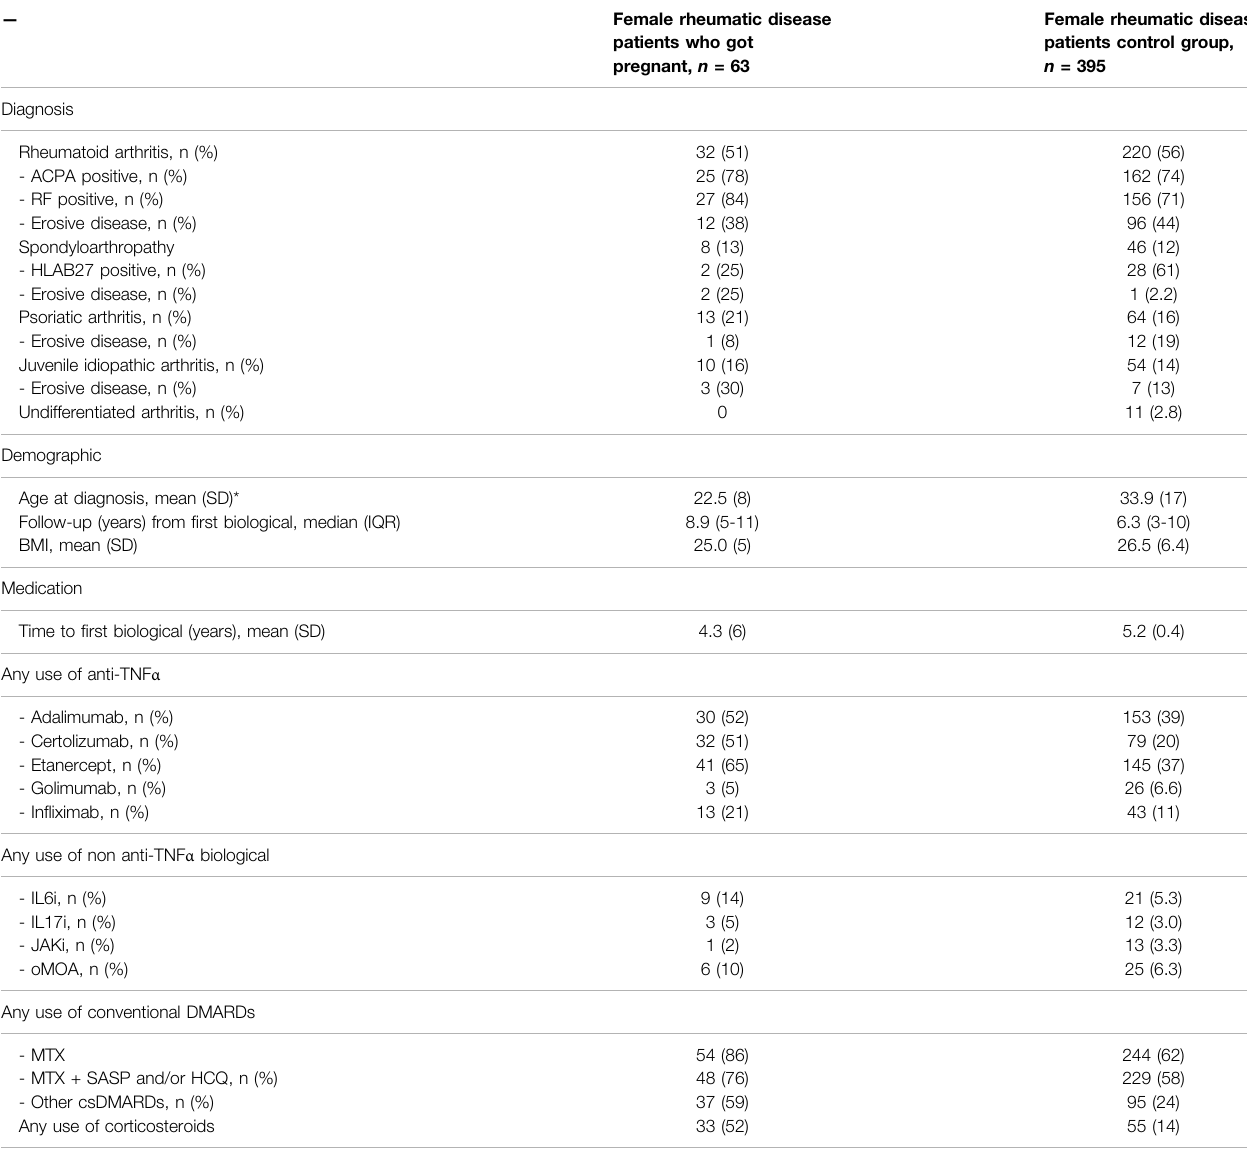
Female rheumatic disease patients control group, n = 395